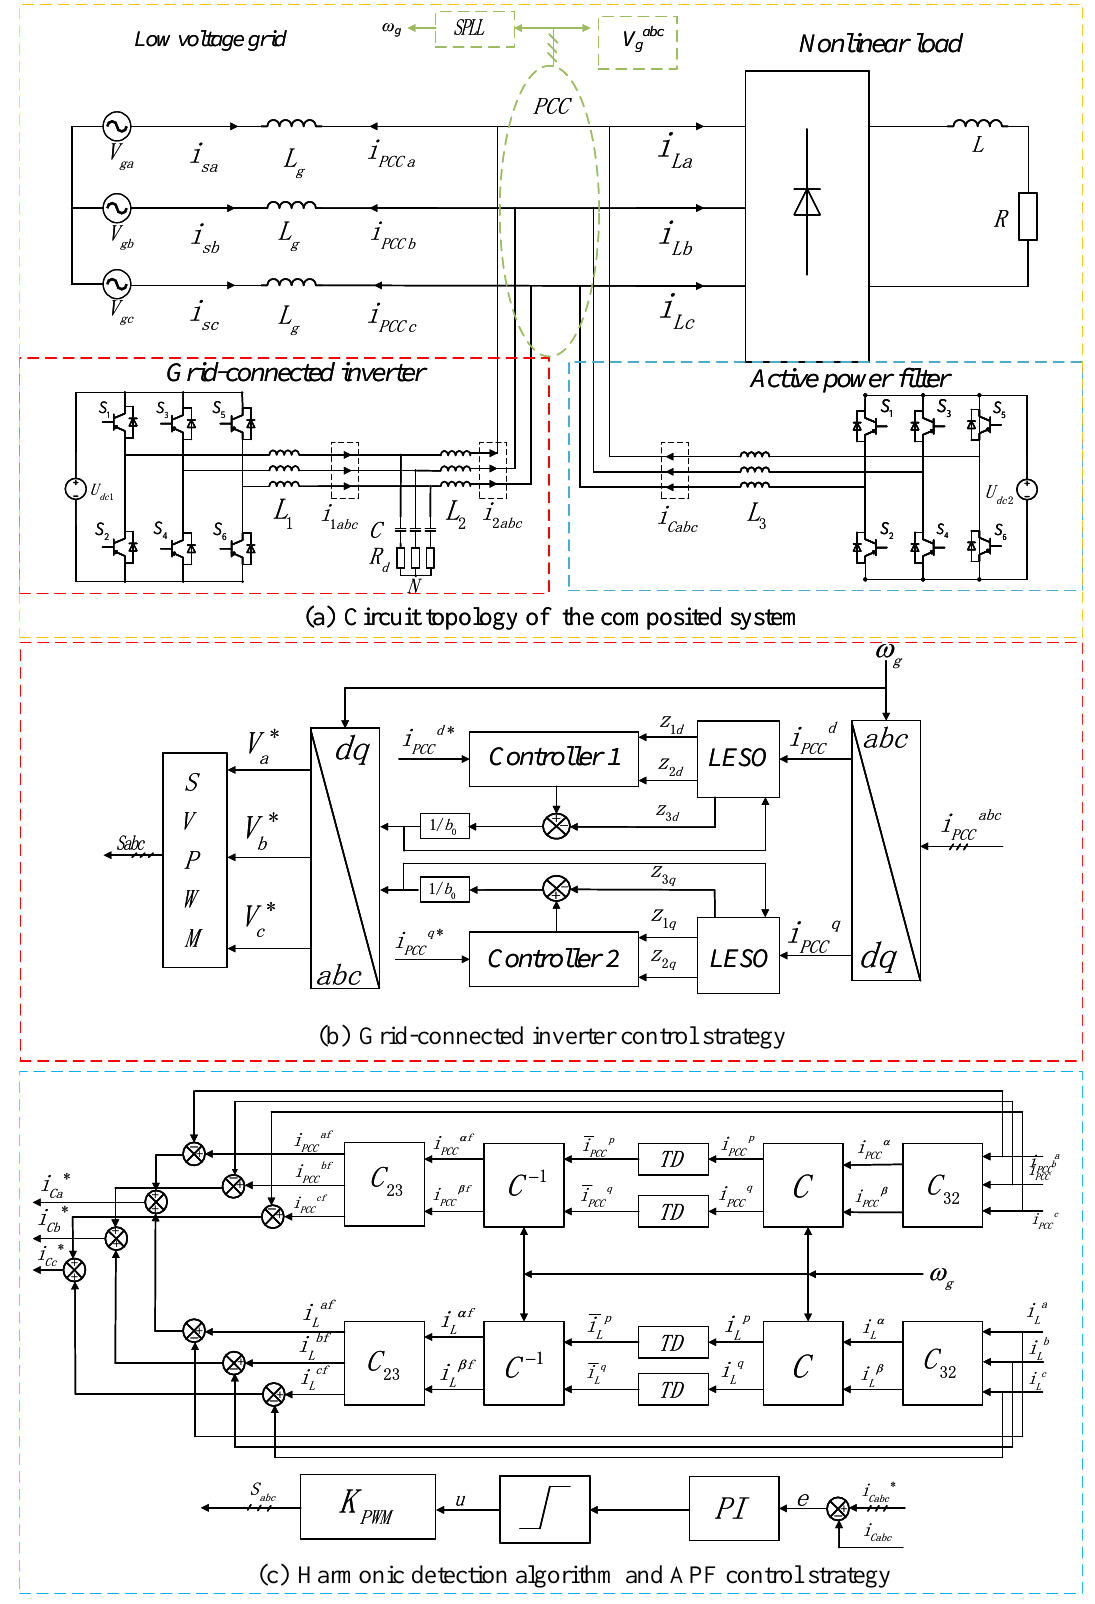
Figure 1. Circuit topology and control strategy of LCL-type grid-connected inverter and an active power filter